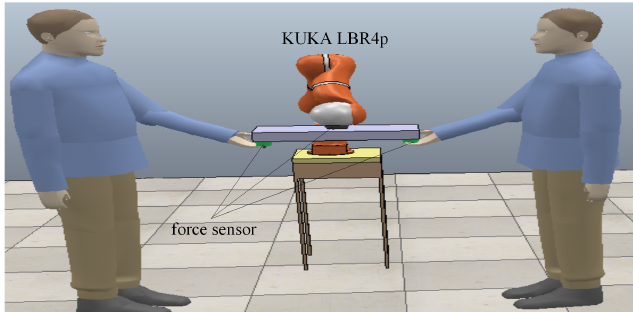
Figure 3. Simulation of cooperative object transporting task. The humans cooperate with the robot to transport the object back and forth between − 10 cm and +10 cm along the horizontal direction. The forces that are exerted by the humans on the object are measured by force sensors at the interaction